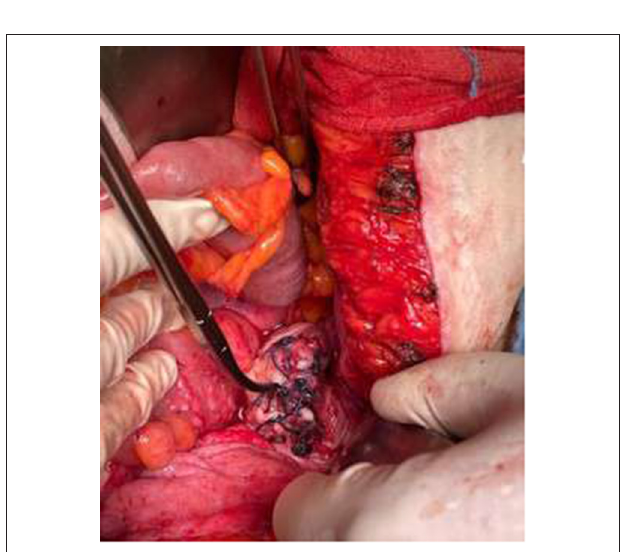
FIGURE 3 | Interrupted stiches on the